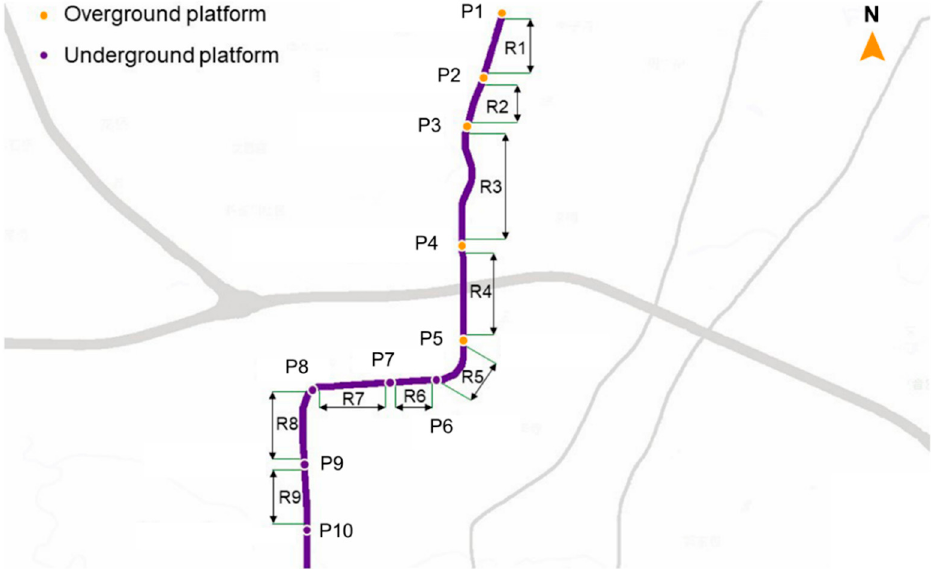
Figure 1. The map of measured routes. P1–P10 represent the 10 platforms